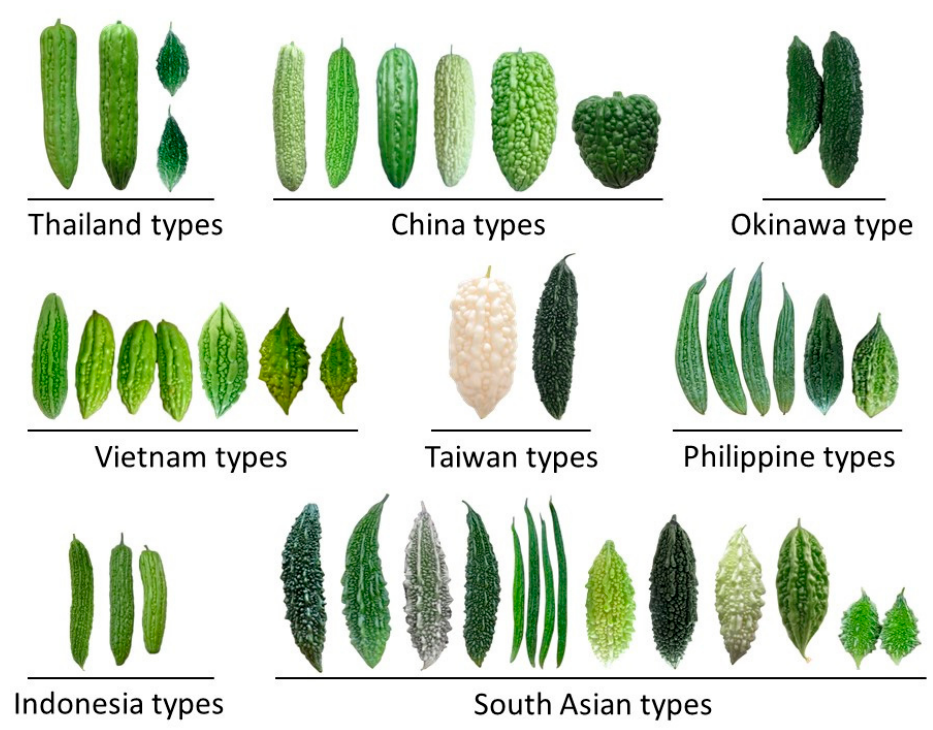
Figure 1. Various market segments for bitter gourd based on fruit color, shape, and skin pattern. Bitter gourd cultivars, Jade Star and Vivek were the first F 1 hybrids released in the early 1980s in the Philippines and India by East-West Seed and Mahyco, respectively, and this breakthrough transformed bitter gourd in Asia from a semi-commercial crop into a major commercial crop. More seed companies initiated bitter gourd breeding programs, often using a small number of closely related bitter gourd lines in commercial breeding and focusing primarily on elite × elite crosses to capitalize on previous breeding successes. This resulted in a narrowing of the genetic diversity within the bitter gourd crop.